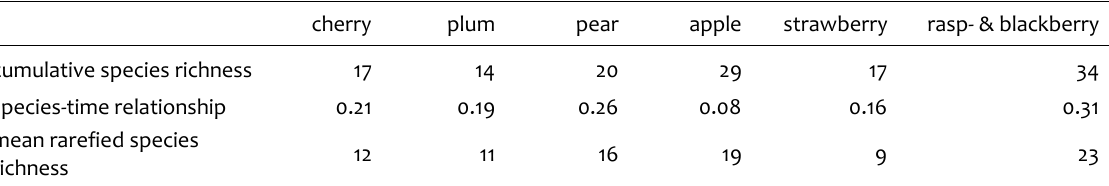
Table 6. Cumulative species richness, species-time relationship and mean rarefied species richness of wild bees per plant species. Total wild bee species richness = 52 species, total observation time = 137 h 30 min.